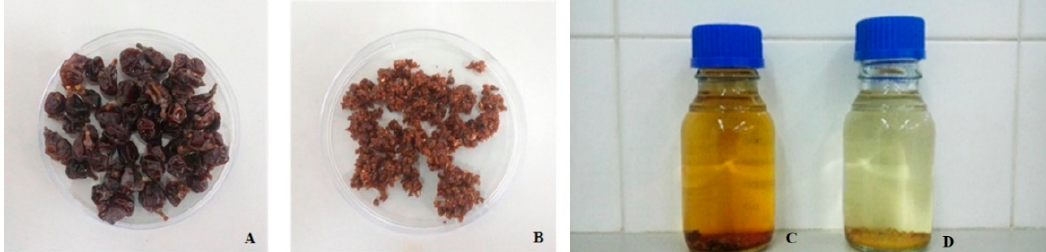
Figure 5. Dried ( A ) and triturated ( B ) non-fermented grapes, containing skins and seeds, of